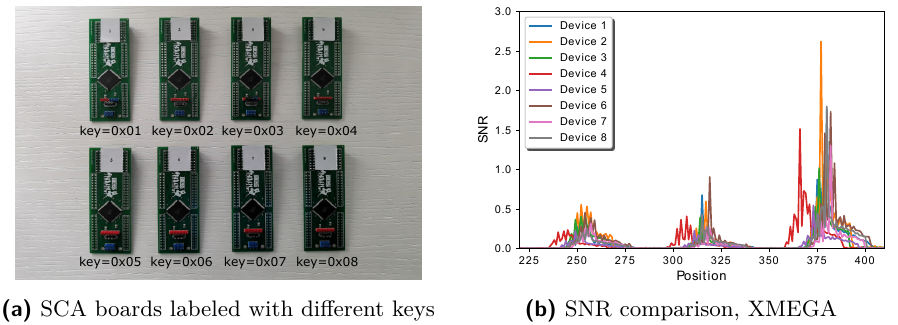
Figure 6: Eight XMEGA boards and their difference from the perspective of